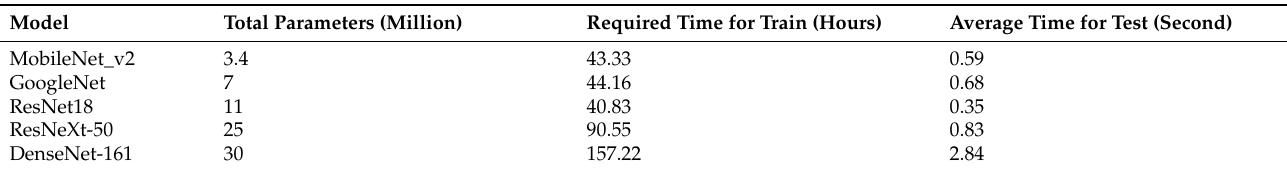
Table 7. Comparative analysis regarding the computation costs (number of parameters, training time, and average test time) of different